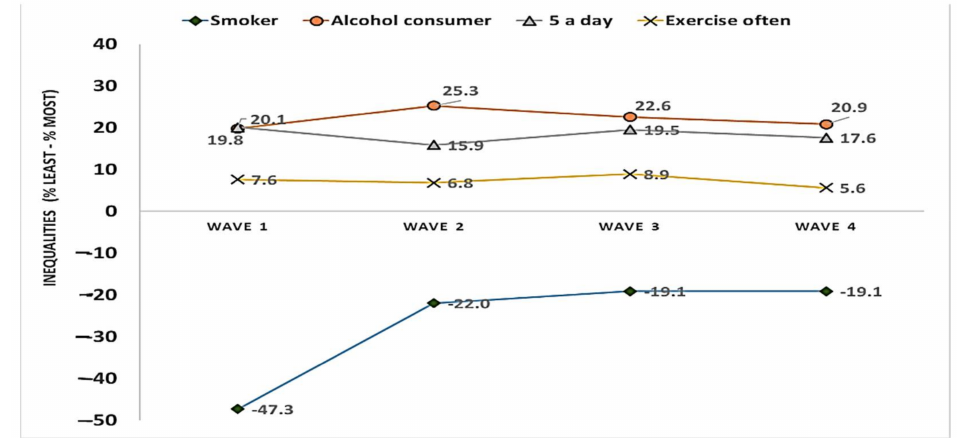
Figure 4. Trends in the inequalities in health behaviours (difference: % least deprived–% most deprived) between most- and least-deprived areas of Stockton-on-Tees, over four waves (18